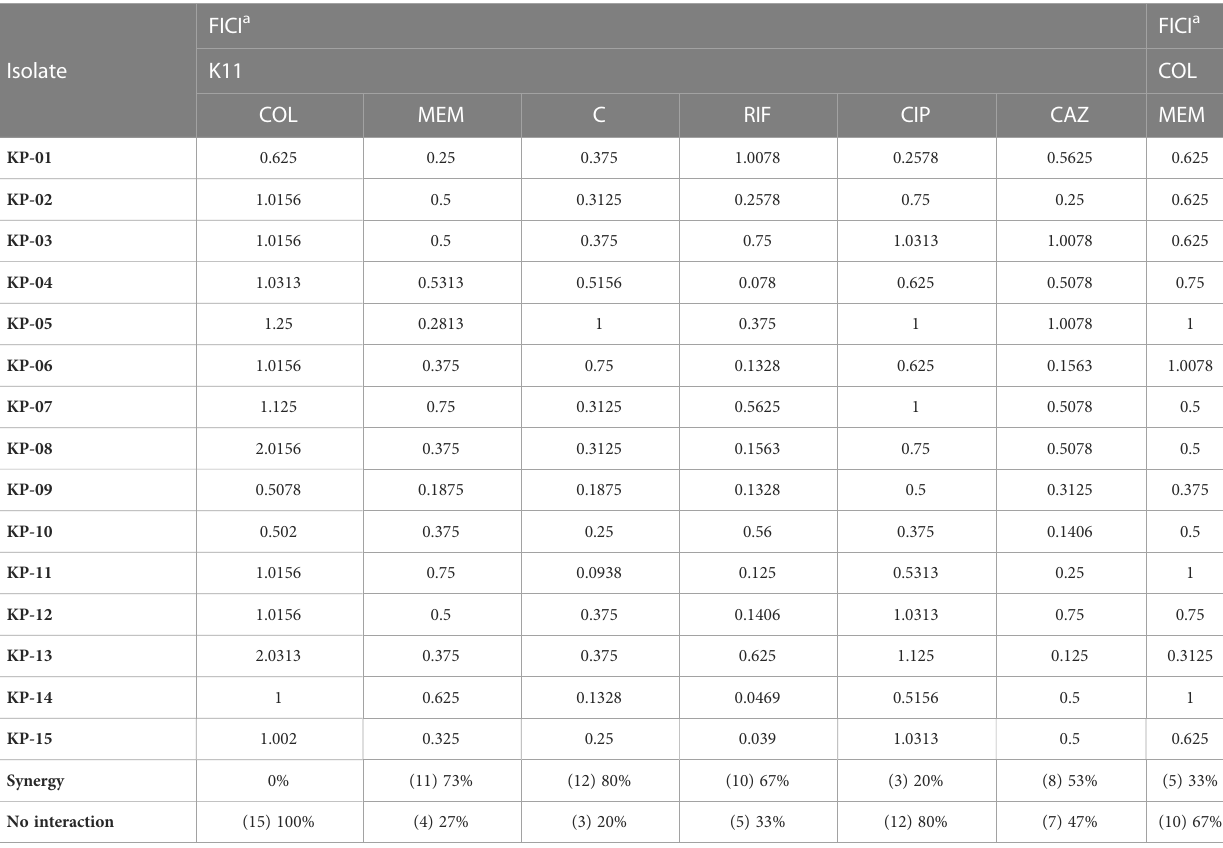
TABLE 2 FICIs of K11 combined with conventional antibiotics to treat clinically isolated MDR/XDR K. pneumoniae .